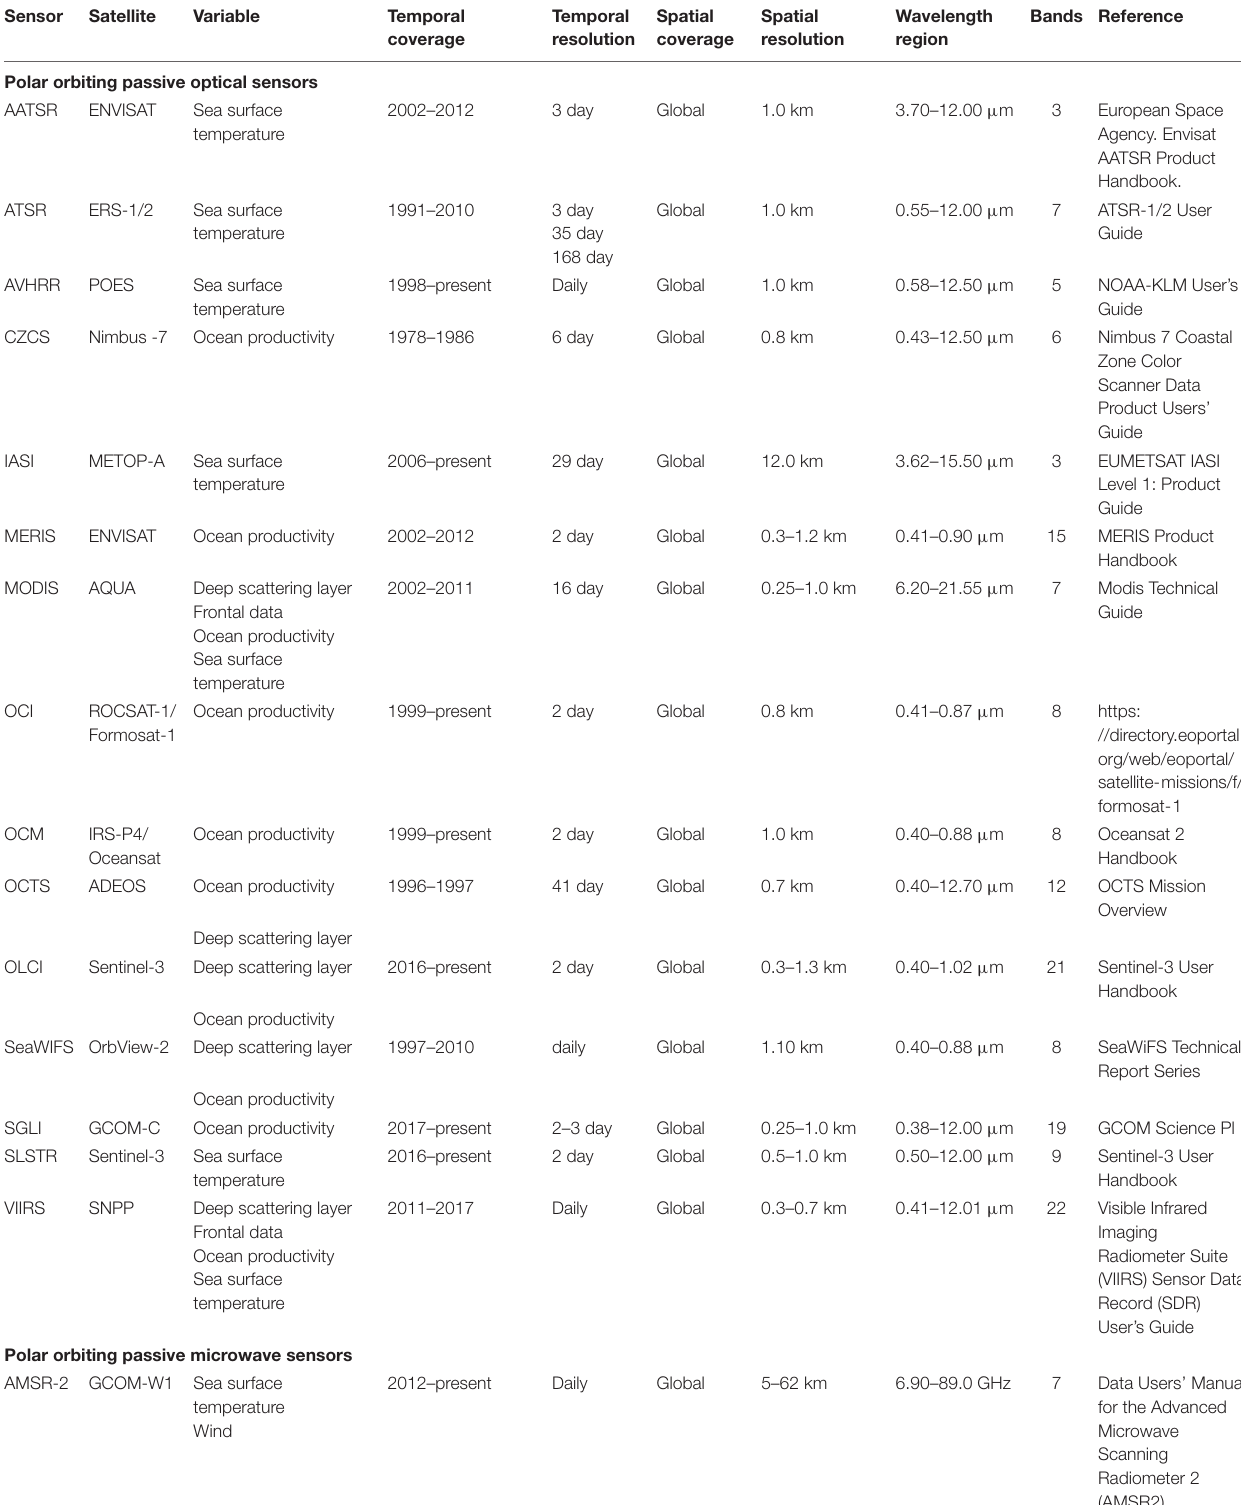
TABLE 3 | Summary of satellite sensors used to obtain marine environmental variables, including details of temporal and spatial coverage and resolution, wavelength region sampled and number of spectral bands.